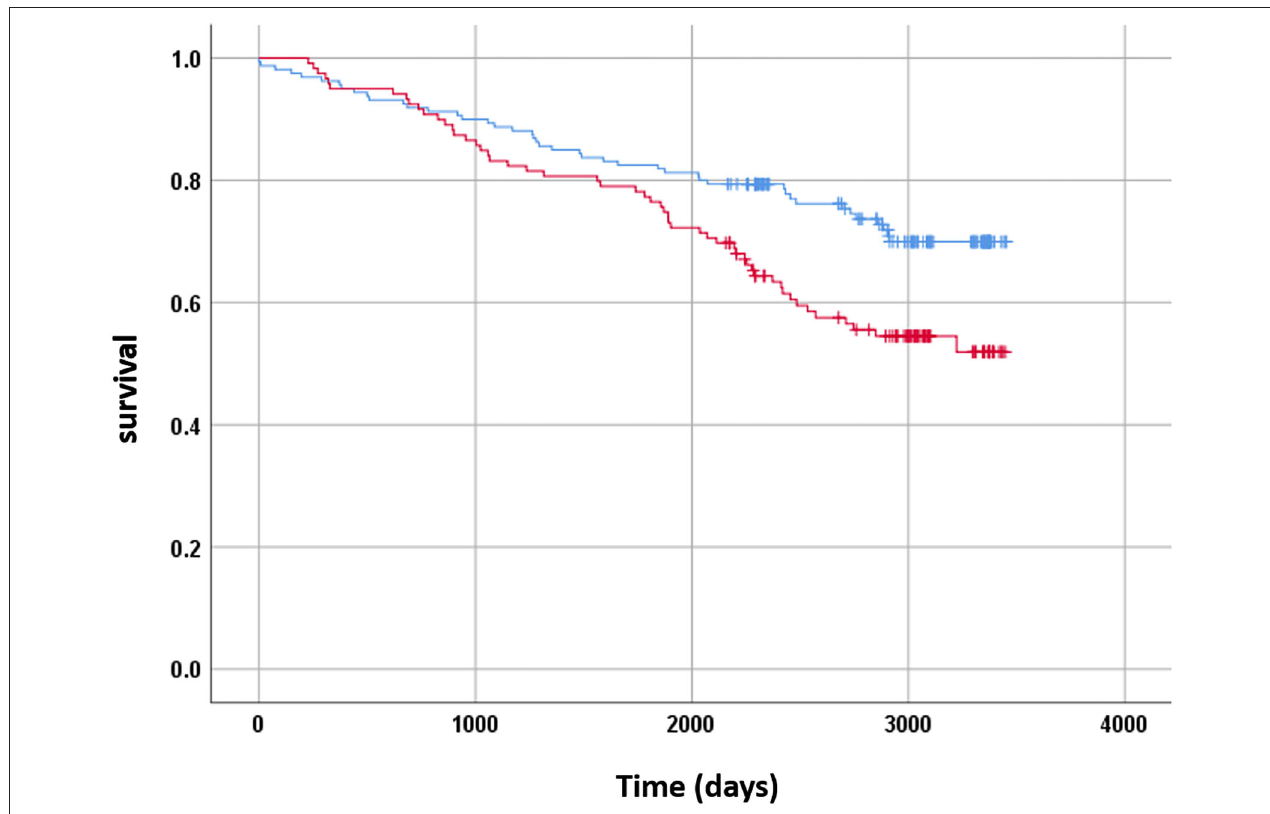
FIGURE 2 | Kaplan-Meier analysis showing rates of CV outcome or death in relation to microalbuminuria. X axis shows days since urine collection, Y axis shows cumulative survival. Blue curve—patients without microalbuminuria, red curve—patients with microalbuminuria.